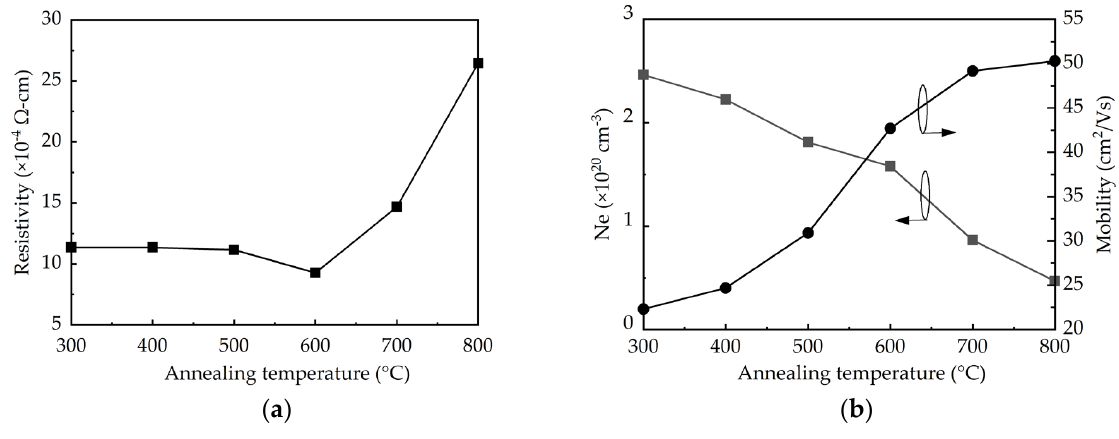
Figure 4. ( a ) Resistivity, ( b ) carrier concentration, Ne, and mobility determined by Hall-effect measurements as a function of annealing temperature.